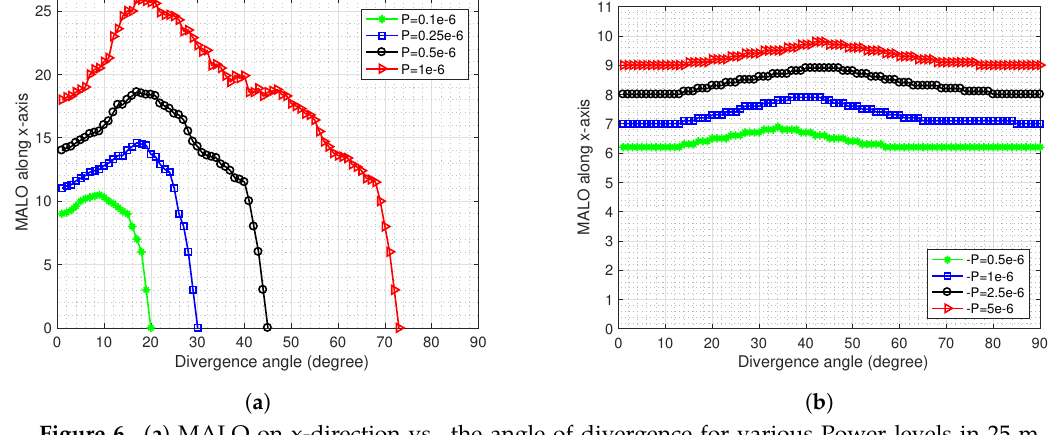
Figure 6. ( a ) MALO on x-direction vs. the angle of divergence for various Power levels in 25 m clean water; ( b ) MALO on x-direction vs. the angle of divergence for various Power levels in 10 m turbid water.